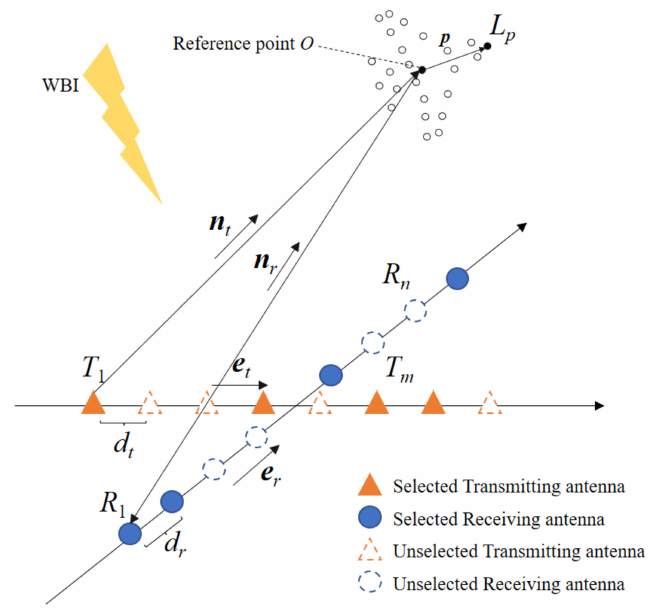
Figure 1. The geometry of the considered 2D sparse cross MIMO radar